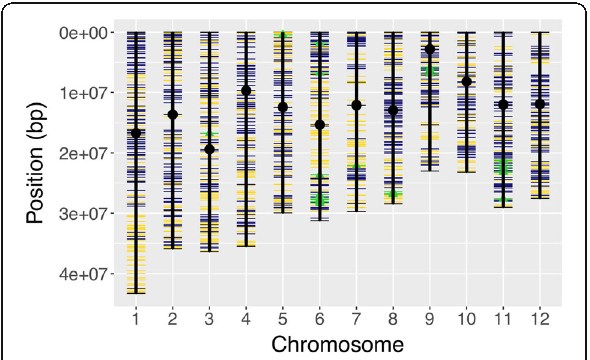
Fig. 1 1k-RiCA SNPs physical positions. Genome-wide physical position distribution of 995 SNPs from the 1k-RiCA-assay across all rice chromosomes. SNPs designed from the C6AIR (Thomson et al. 2017) are represented in blue color, SNPs from the ‘ 3000 rice genomes ’ are in yellow (Mansueto et al. 2017, and Wang et al. 2018), and trait-markers are in